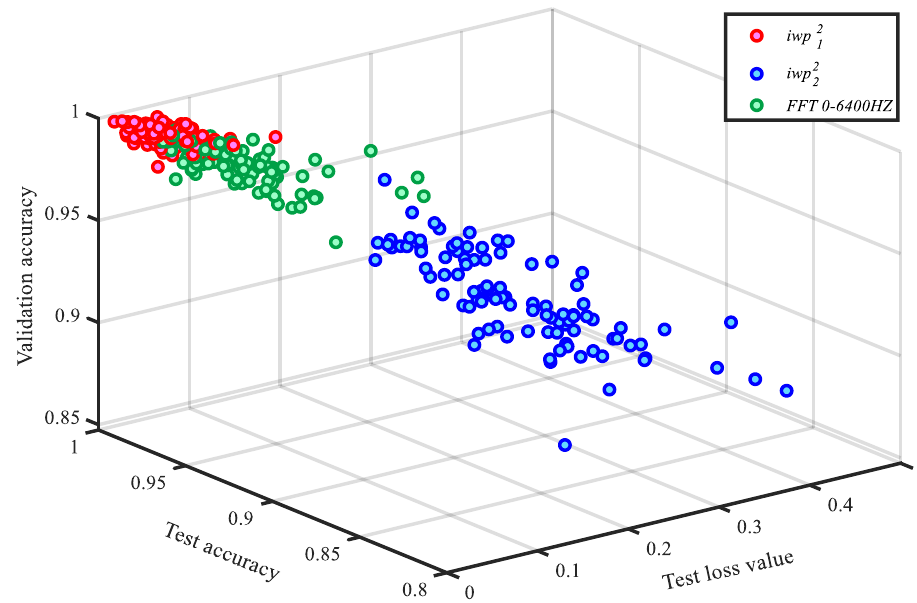
Figure 19. Performance comparison of data sets constructed with different frequency bands.